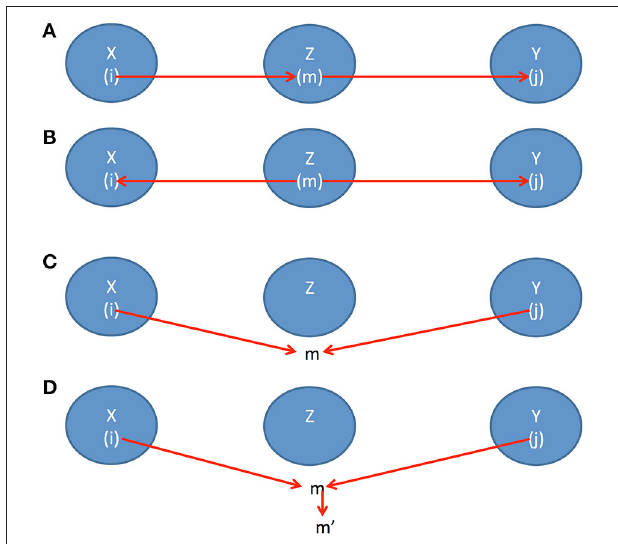
FIGURE 1 | (A) Causal direction 1, (B) Causal direction 2, (C) Causal direction 3, and (D) Causal direction